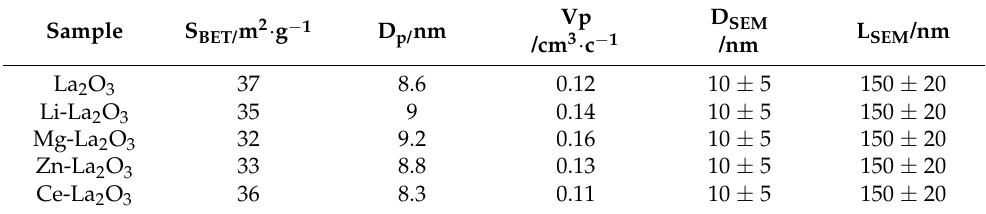
Figure 1. XRD pattern of the La 2 O 3 and X-La 2 O 3 catalysts. ( a ) La 2 O 3 ; ( b ) Li-La 2 O 3 ; ( c ) Mg-La 2 O 3 ; ( d ) Zn-La 2 O 3 ; ( e ) Ce-La 2 O 3 . Table 1. BET surface area, pore size, supported nanoparticle size of pure La 2 O 3 and X-La 2 O 3